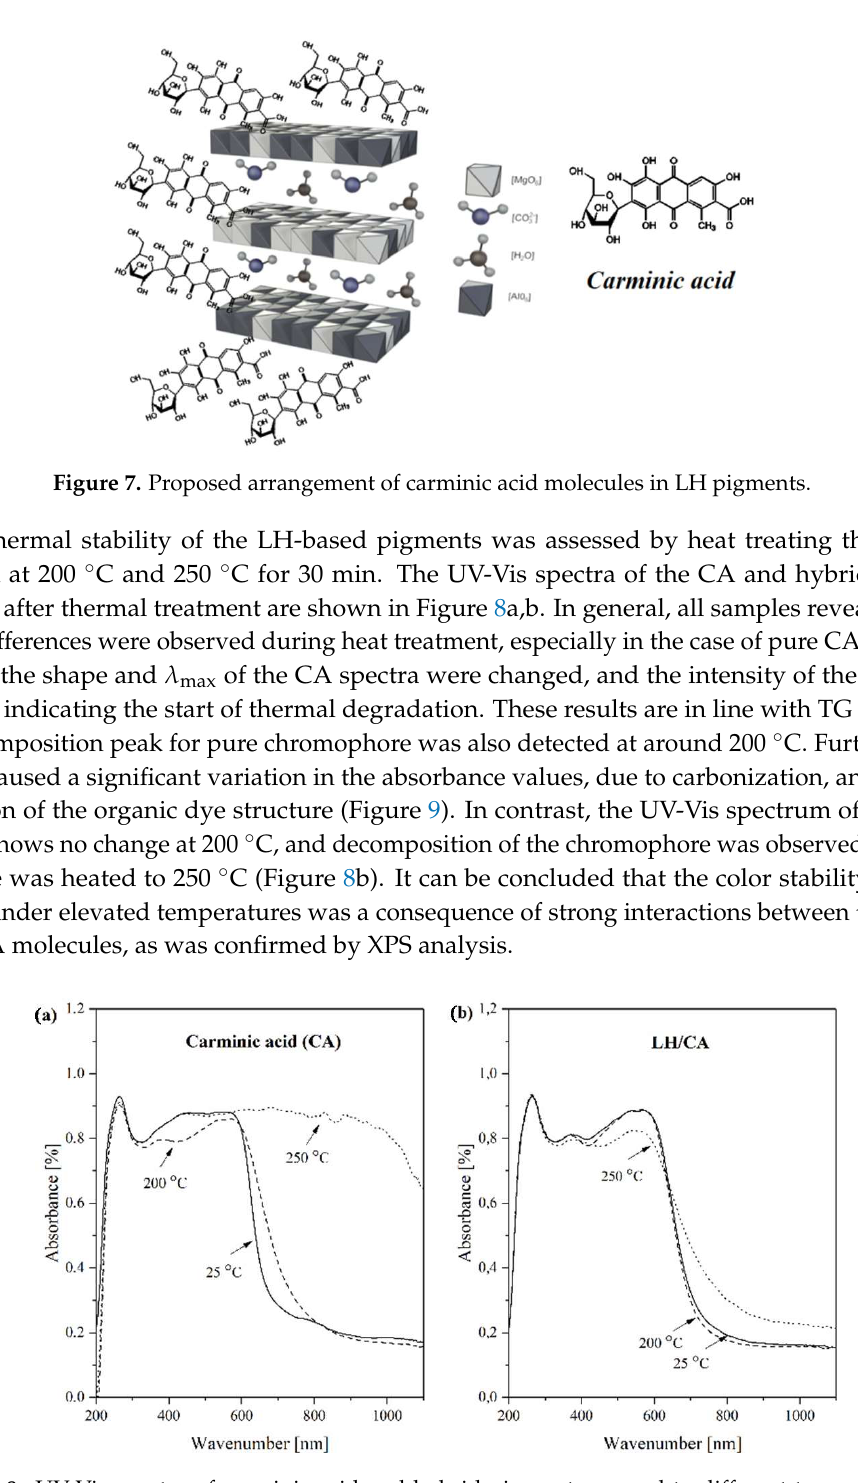
Figure 8. UV-Vis spectra of carminic acid and hybrid pigment exposed to different temperatures: ( a ) carminic acid and ( b ) LH/CA 20%.